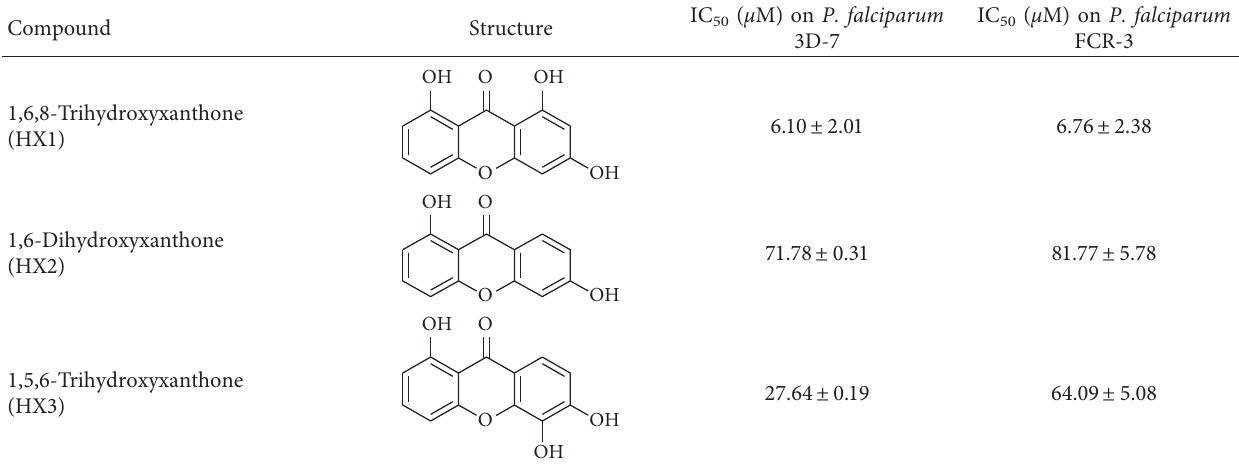
Table 2: The IC 50 values of hydroxyxanthone derivatives on Plasmodium falciparum 3D-7 and FCR-3 after 72 hours incubation period using microscopic